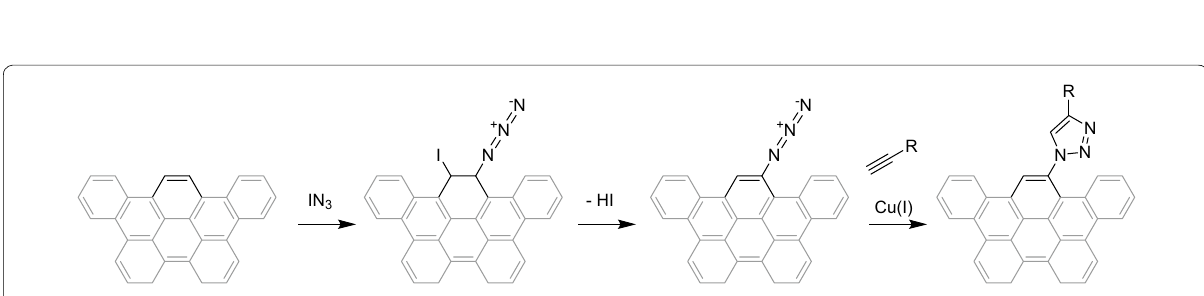
Fig. 1 a Oxidative functionalization of carbon surfaces. Reproduced from [44] with copyright permission from 1993 Elsevier Ltd. b Preparation of graphene derivatives from fluorographene. Reproduced from [54] with copyright permission from 2017 Elsevier Ltd.